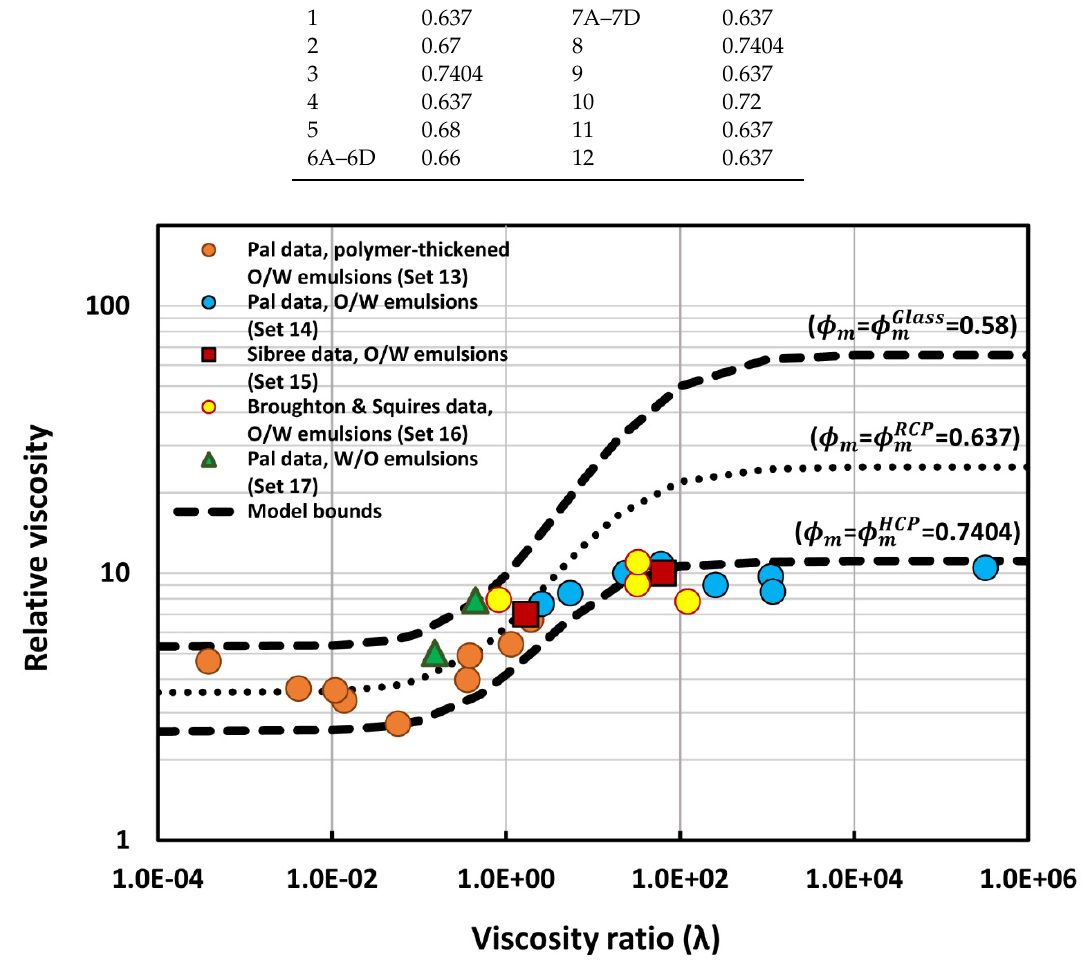
Figure 24. Comparison of experimental viscosity data for emulsions with the prediction of the proposed emulsion model, Equation (44), at a fixed φ value of 0.5 but varying viscosity ratio λ .